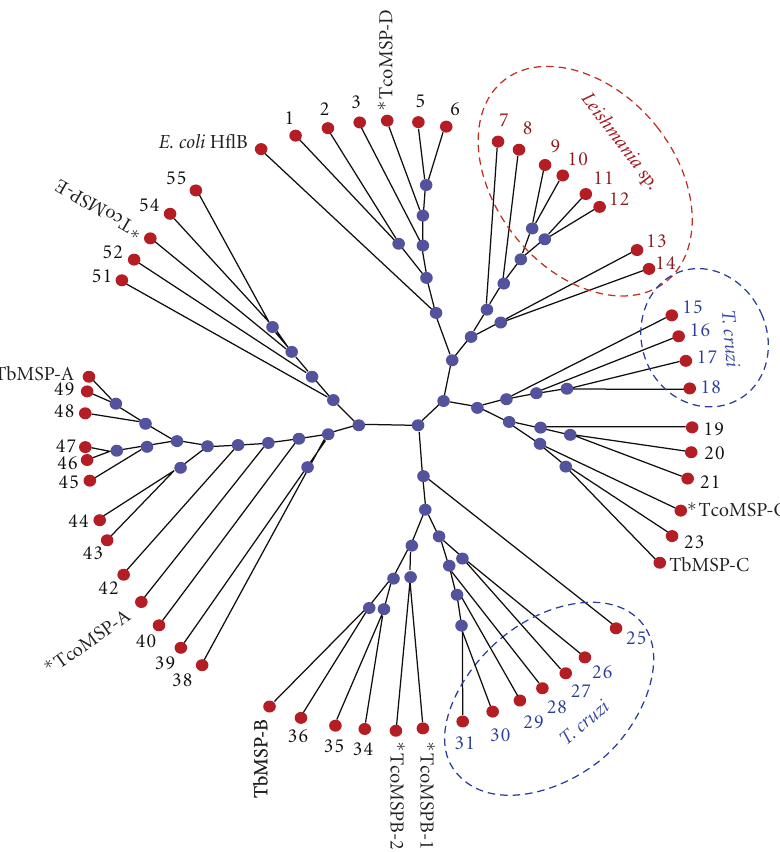
Figure 3: Clustal-W generated dendogram comparing T. congolense putative MSPs with predicted homologues from T. brucei TREU927, T. brucei gambiense, T. vivax, T. brucei rhodesiense , T. cruzi , and Leishmania sp . (taxid 5658). Predicted protein sequences were obtained in